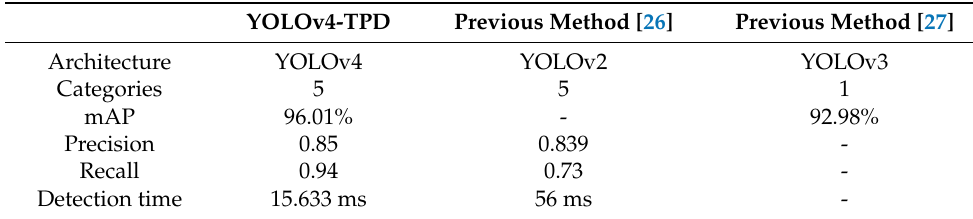
Table 4. The comparison of experimental results with previous methods.